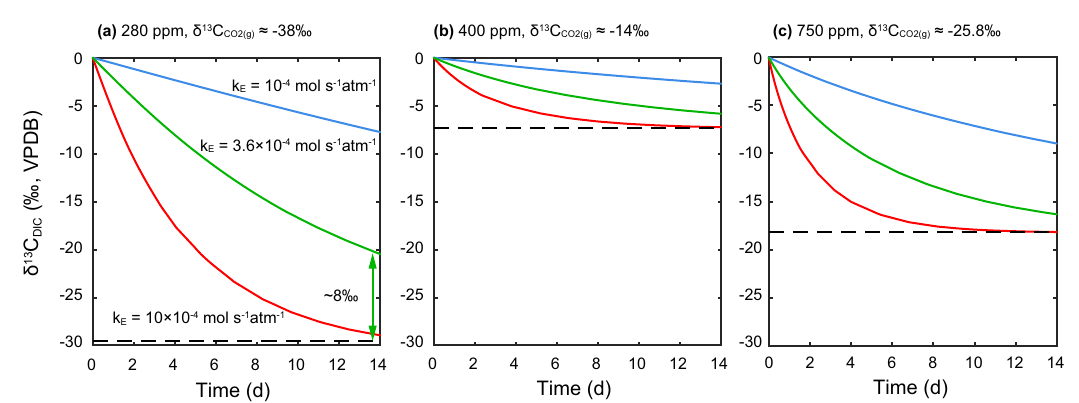
Fig.2|SimulatedDICcarbonisotoperatiosevolutionduringbubbling. Panela, b, c are simulations for different p CO2 and initial δ 13 C DIC . Blue curves: k E =10 − 4 mols − 1 atm − 1 (a slower equilibrium). Red curves: k E =10 − 3 mols − 1 atm − 1 (a faster equilibrium). Green curves: k E =3.6 ×10 − 4 mols − 1 atm − 1